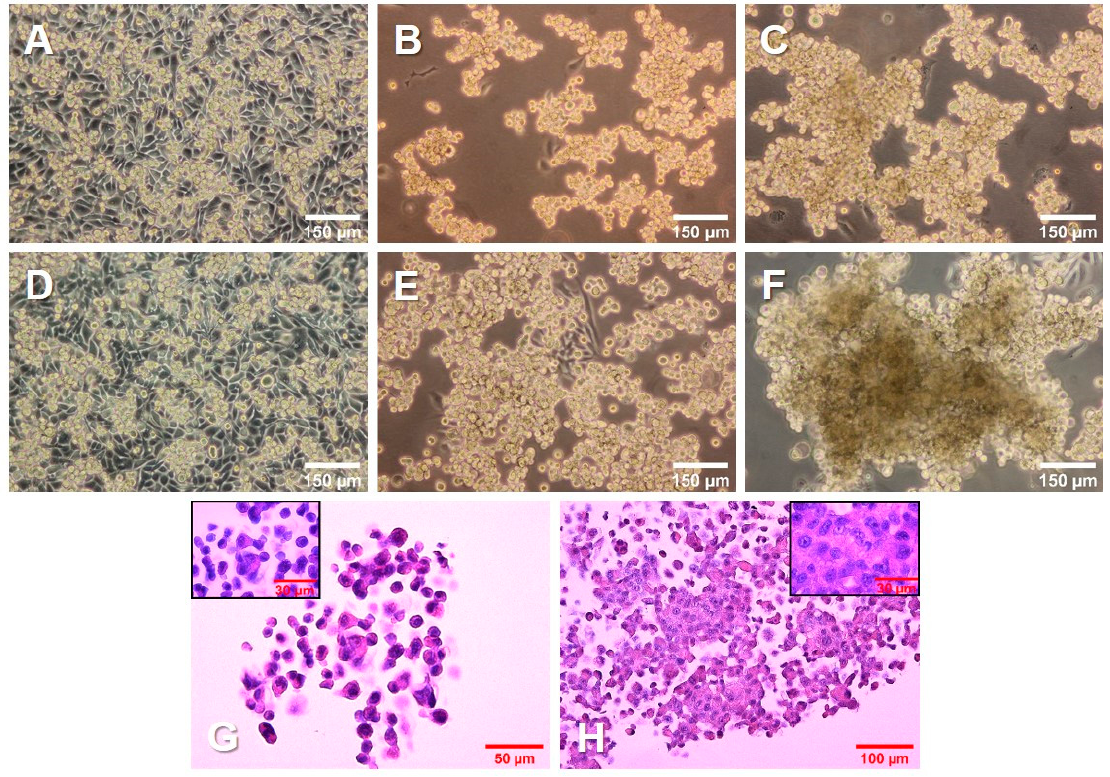
Figure 1. Growth of PC-3 prostate cancer cells in simulated microgravity. PC-3 cells were cultured ( A , D ) under 1 g conditions or ( B , C , E , F ) on an RPM for 3 days ( A – C ) and 5 days ( D – F ). ( G , H ) PC-3 cells growing in MCS, stained with hematoxylin and eosin (HE) after a 3-day ( G ) and 5-day ( H ) RPM exposure, respectively.